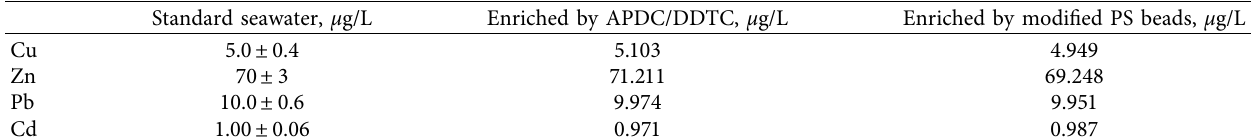
Table 2: Detection of commercial standard seawater.